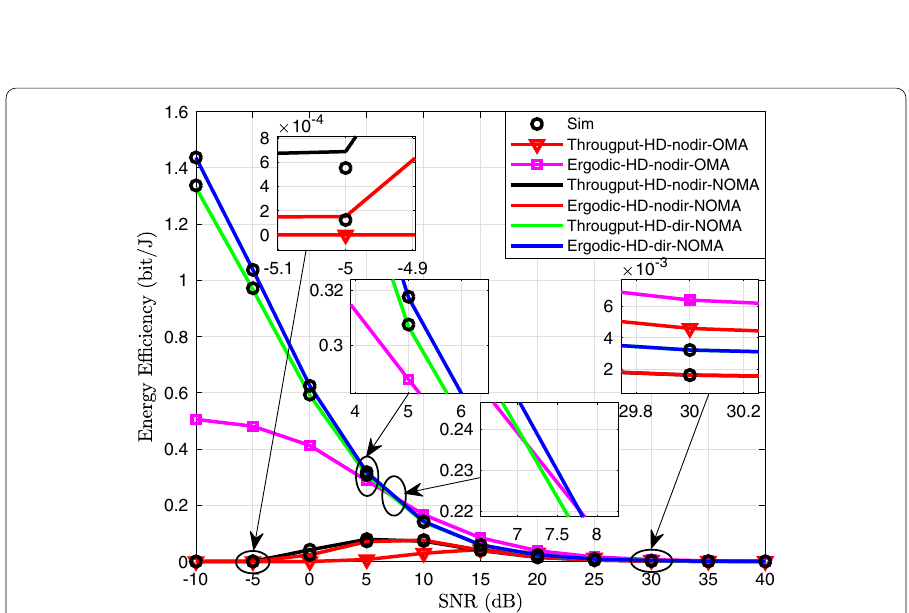
Fig. 7 Energy efficiency of two users for the PSR protocol in cases of without direct link and direct